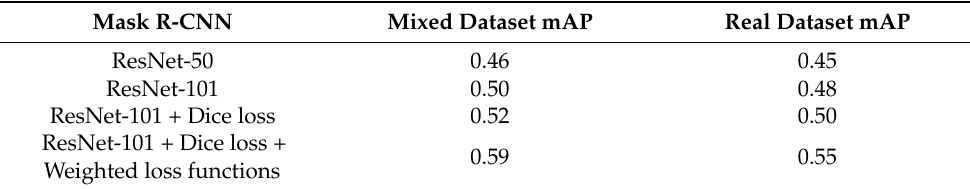
Figure 16. Mean average precision. Table 6. Mean average precision.